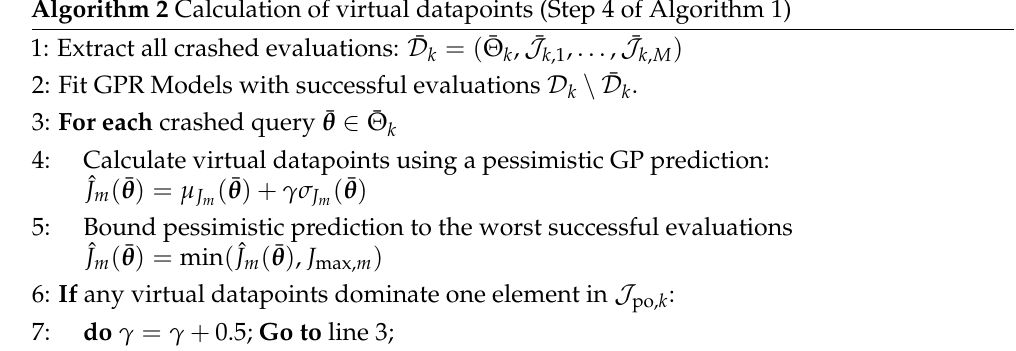
Algorithm 2 Calculation of virtual datapoints (Step 4 of Algorithm